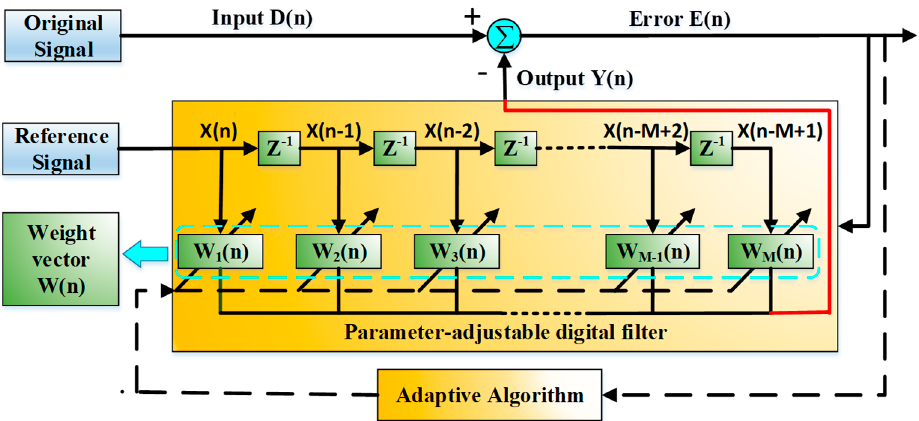
Figure 5. Schematic diagram of adaptive filtering based on least mean square error (LMS) algorithm.